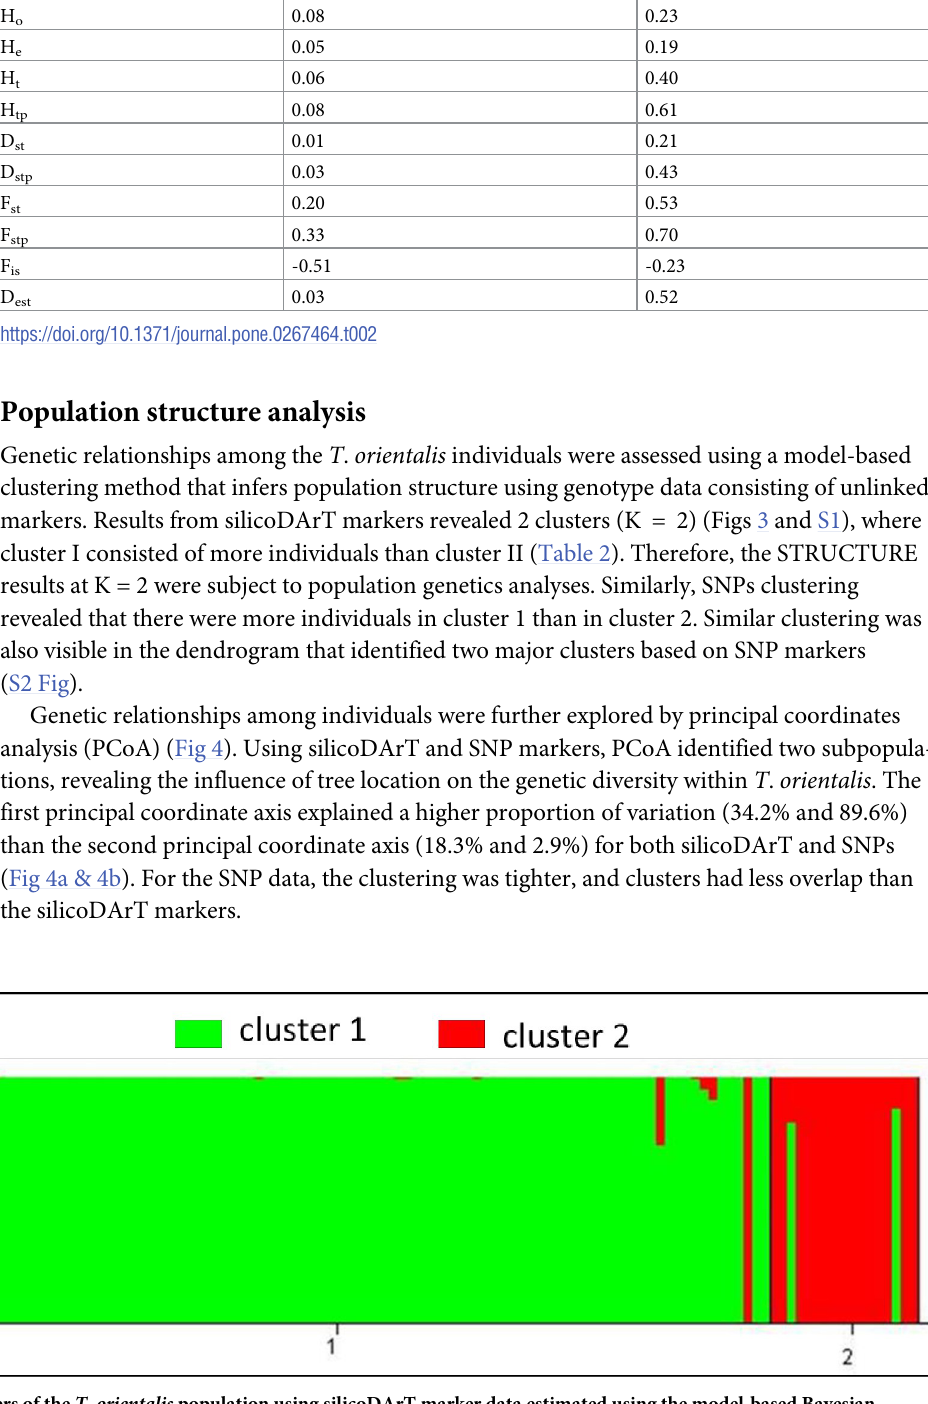
Fig 3. Number of clusters of the T . orientalis population using silicoDArT marker data estimated using the model-based Bayesian algorithm implemented in the STRUCTURE program. A similar graph was obtained for the SNP markers (graph not shown).